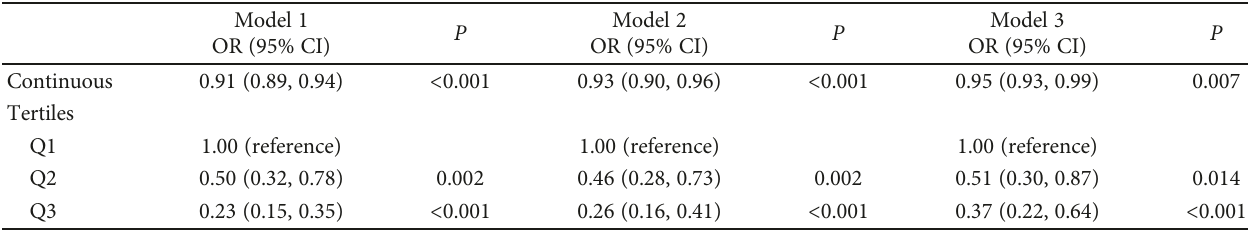
Table 4: Odds ratios (95% CI) for risk of DR according to